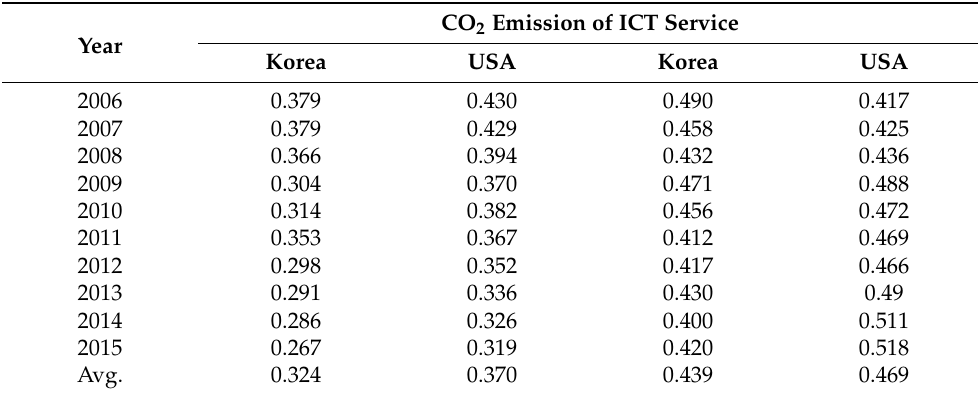
Table 11. Comparison of CO 2 emission of ICT industry between Korea and USA.